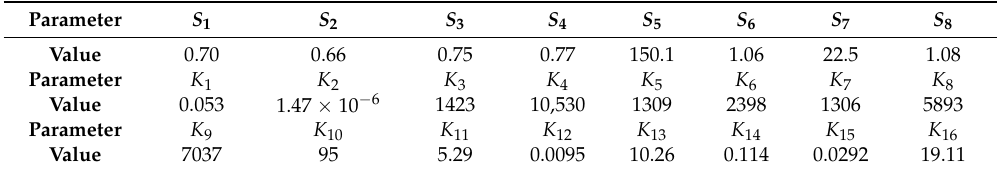
Table 2. Final optimal model